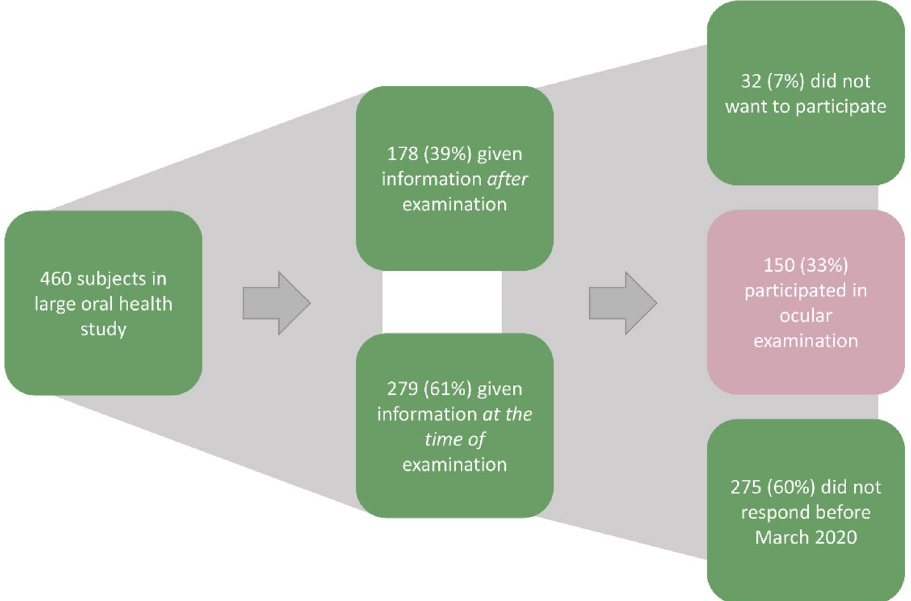
Figure 1. Flow diagram illustrating the recruitment